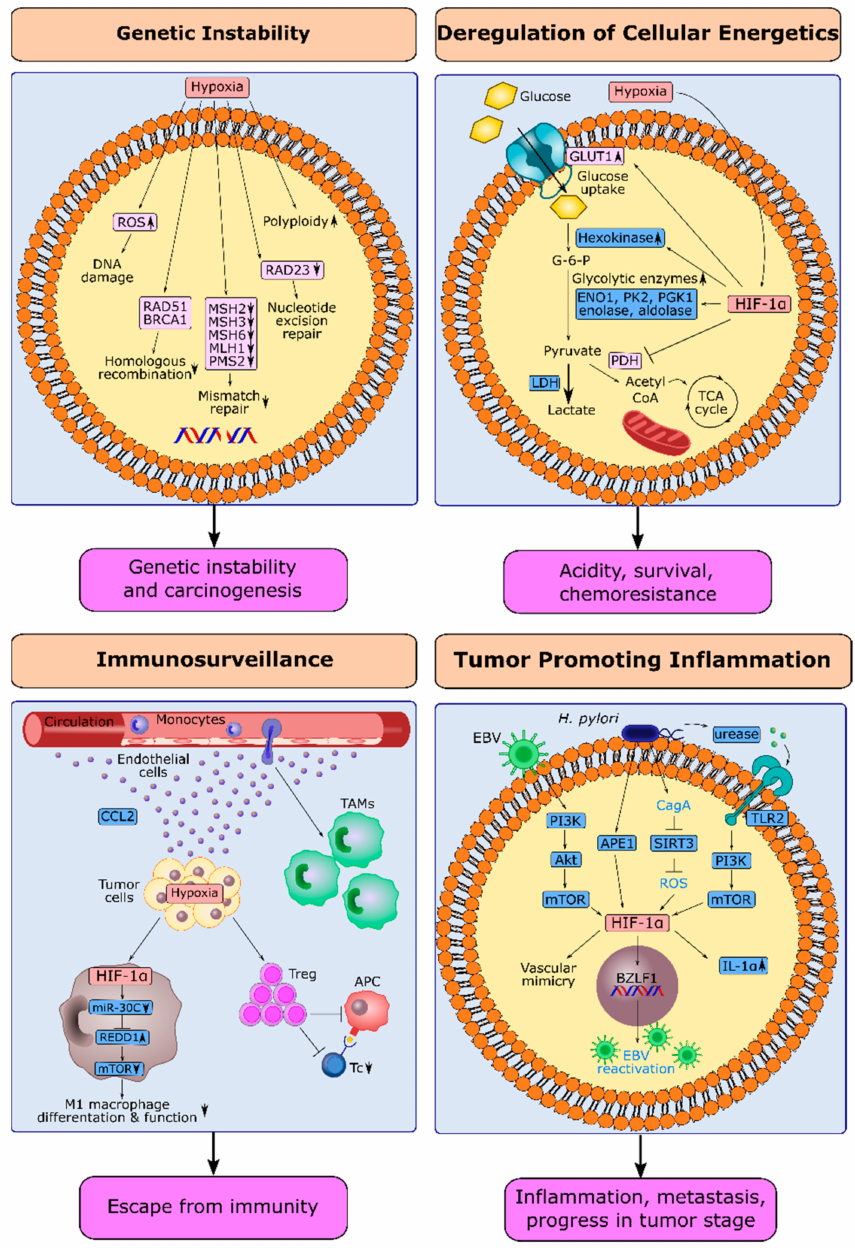
Figure 4. Induction of next-generation cancer hallmarks by hypoxia and HIF-1 α in gastric cancer. Hypoxia induces genetic instability, deregulation in cellular energetics, escape from immune surveil- lance, and tumor-promoting inflammation in gastric cancer. Processes for which there is specific evidence in gastric cancer are shown in blue. Processes common in different cancers are shown in light pink. Upregulation or downregulation of specific proteins is shown with an upward or downward arrow, respectively. The figures were drawn in Inkscape